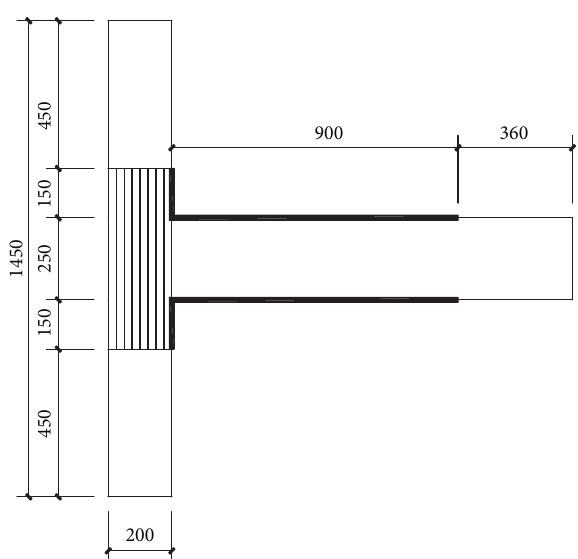
Figure 2: Sticking method and the range of CFRP (unit: mm).